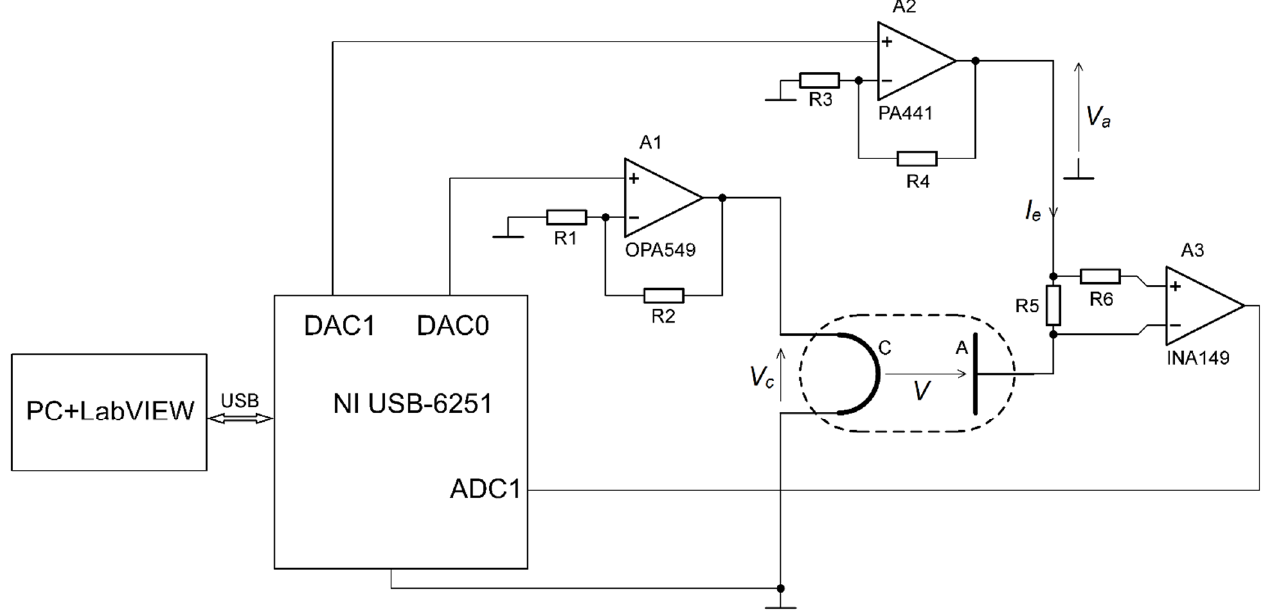
Figure 1. A simplified diagram of the control system electrical circuit. V c is the cathode voltage, I e is the emission current, V a is the anode circuit supply voltage, V is the electron accelerating voltage. R 1 = 12 kOhm; R 2 = 2.4 kOhm; R 3 = 10 kOhm; R 4 = 120 kOhm; R 5 = R 6 = 570 Ohm. The operational amplifier A 1 and differential amplifier A 3 are supplied from the voltage source of +/ − 12 V/5 A, and the operational amplifier A 2 is supplied from the voltage source of 125 V/100 mA. All supplied voltage sources are referenced to the ground.